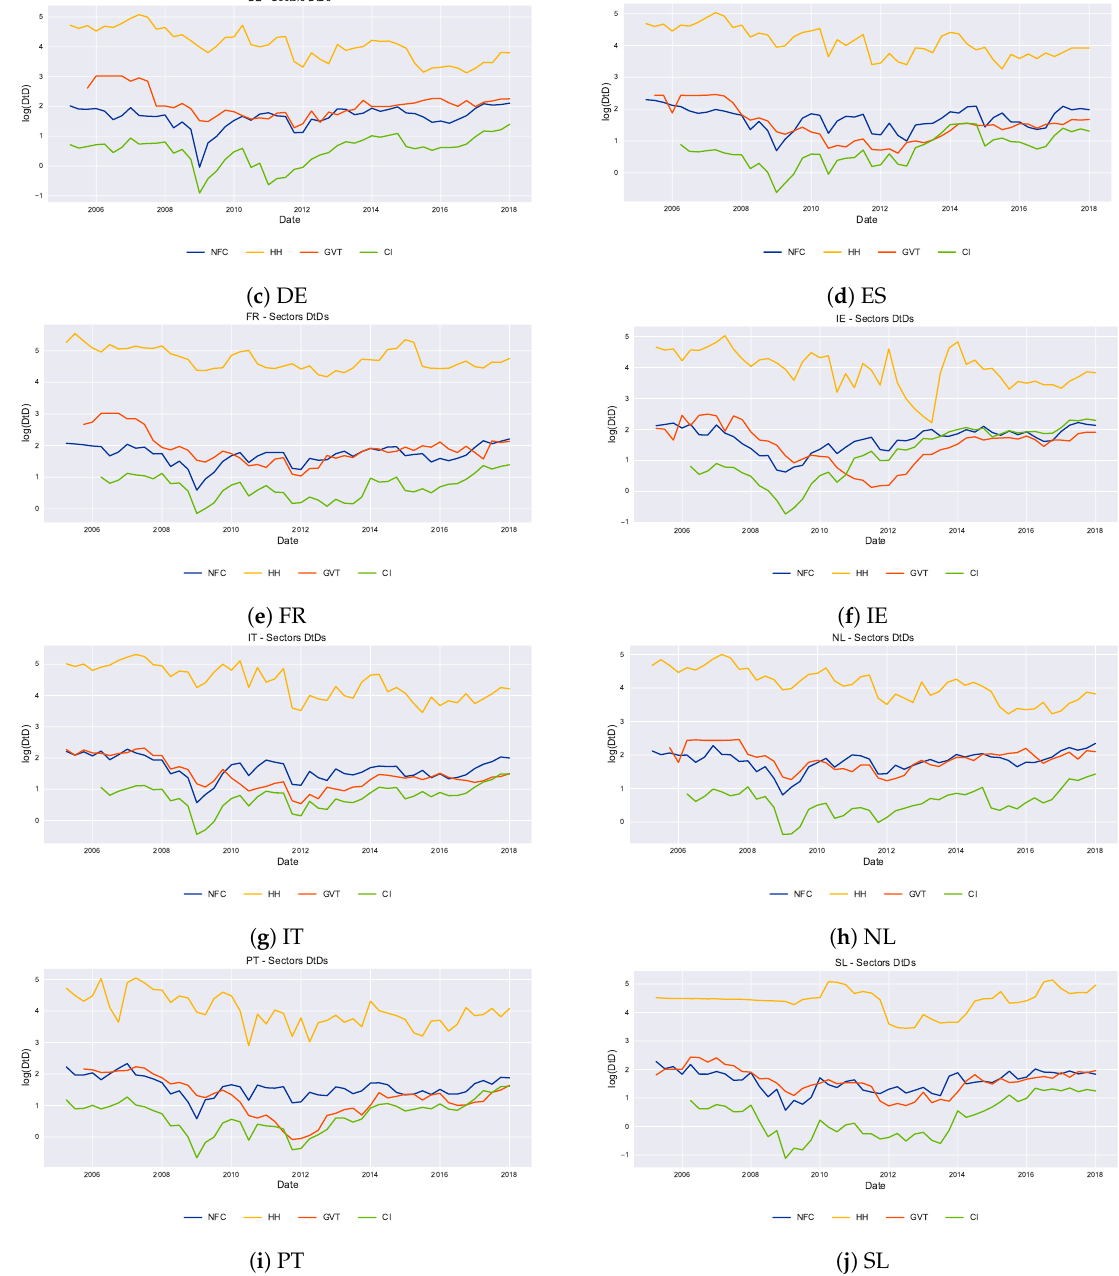
Figure 3. Sectors DtD . The panels show the level of DtD for each sector considered in the analysis for each country (NFCs in blue, HH in yellow, GVT in red and CI in green).The y -axis expresses the DtD measure in standard deviations